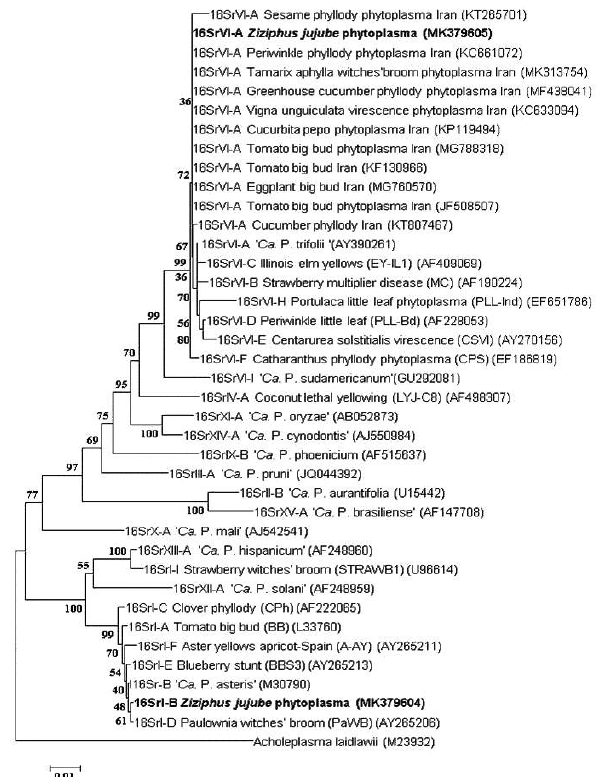
Figure 4. Phylogenetic tree constructed by the Neighbor-Joining method of 16S rRNA gene sequences from 31 phytoplasmas and Acholeplasma laidlawii , as the outgroup. The JWB phytoplasmas are indicated in bold font. Numbers at the nodes are bootstrap values based on 1,000